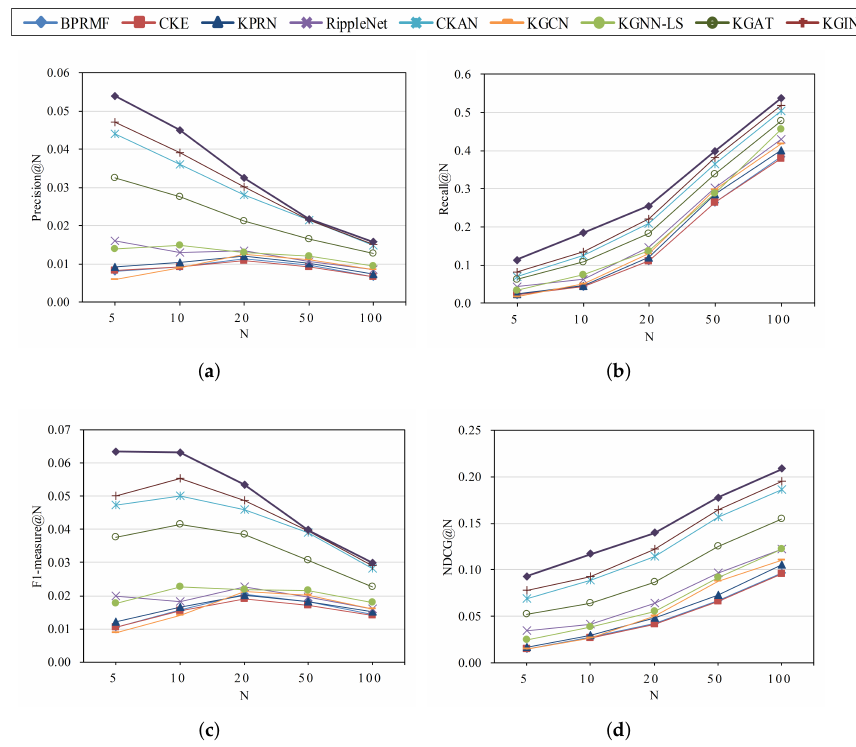
Figure 6. Top-N recommendation performance comparison on the Dianping-Food dataset. ( a ) Prece- sion@N; ( b ) Recall@N; ( c ) F1-measure@N; ( d )